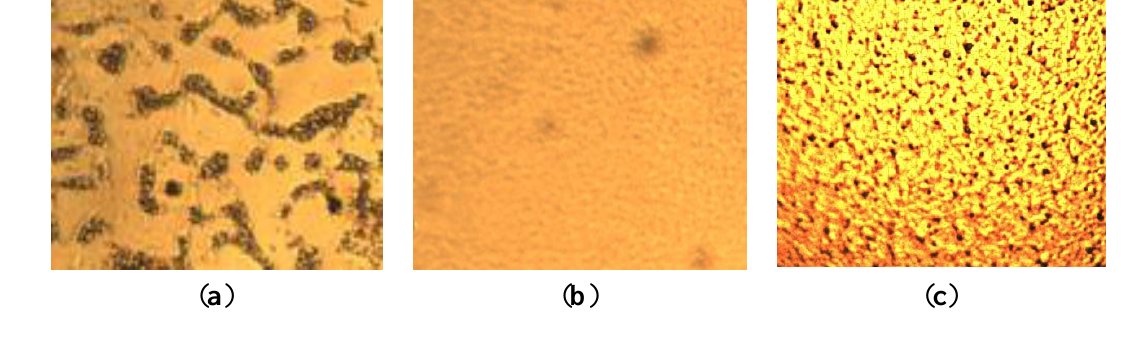
Figure 3. Optical microscope pictures (400×) of PVDF films after solvent-baking under vacuum (under 10 mTorr). The weight percentages of PVDF are: ( a ) 5 wt%; ( b ) 10 wt%; ( c ) 15